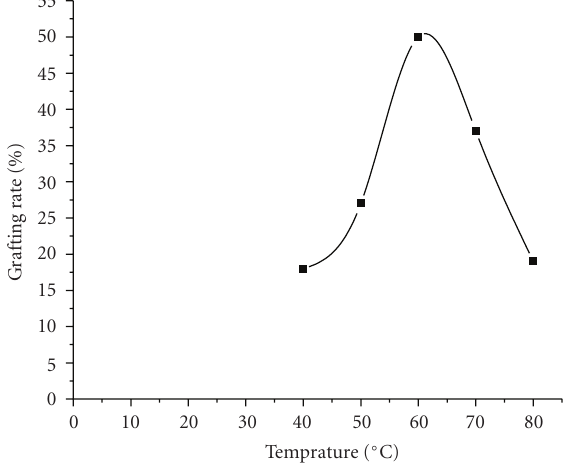
Figure 1: E ff ect of BPO on Percentage of grafting, [MMA] = 10%(V/V) ; [Temperature] = 70 ◦ C; [Time] = 120 minutes; [Nitrogen atmosphere] = 20 minutes; Optimum [BPO] = (0.03M).